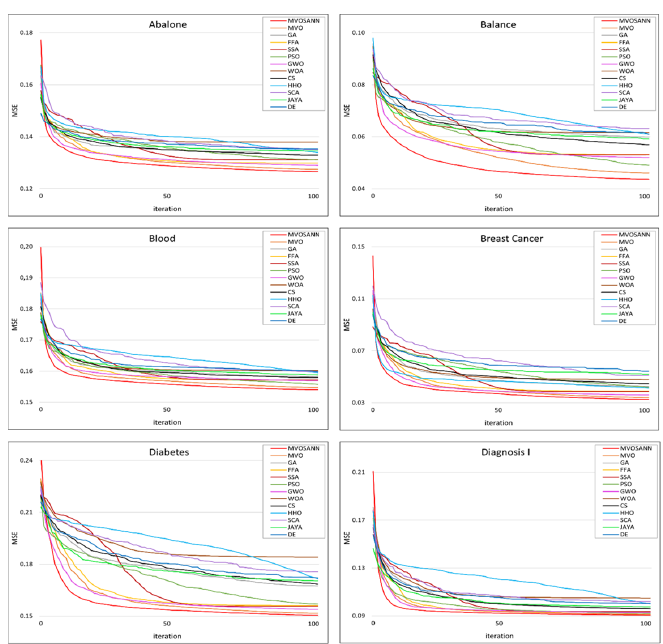
Fig. 7. Convergence curves of Abalone, Balance, Blood, Breast Cancer, Diabetes, Diagnosis I